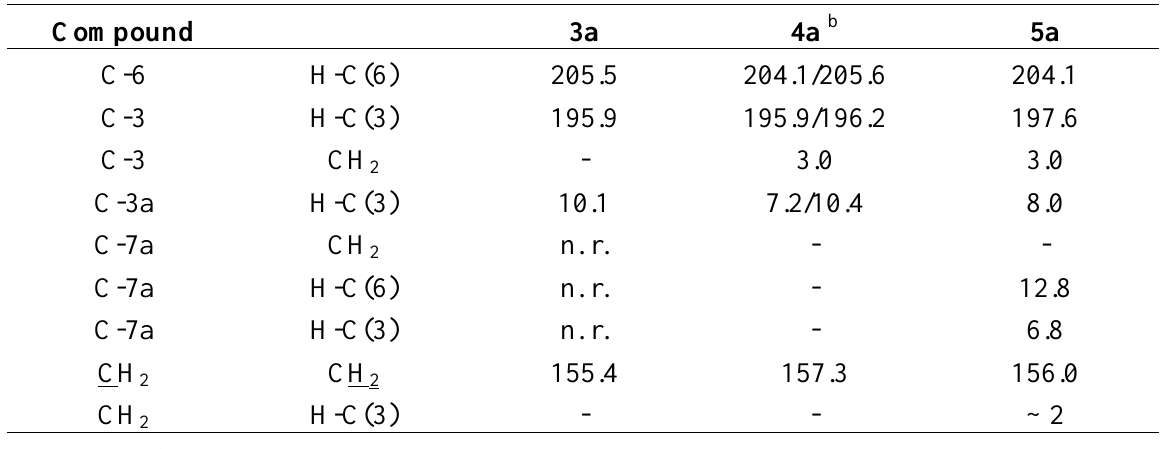
Table 1 . [ 1 H- 13 C] Coupling constants of compounds 3a – 5a a